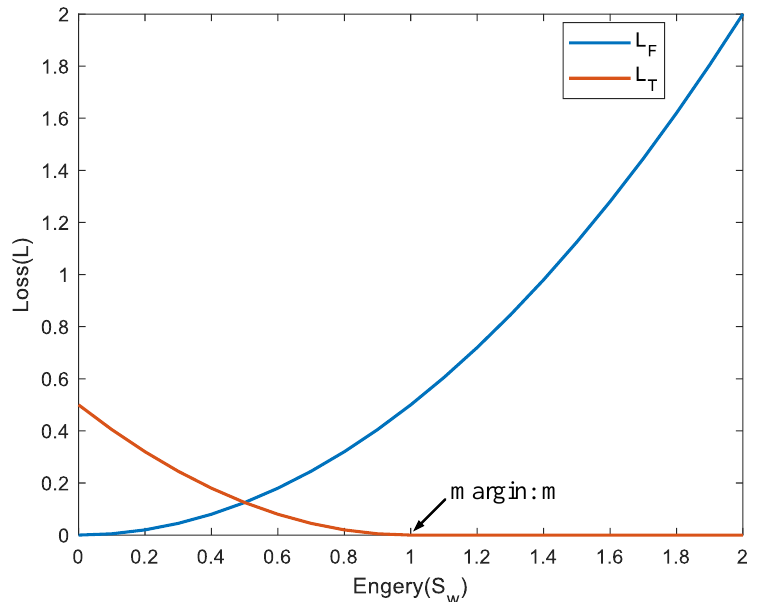
Figure 8. Graph of the loss function L with the energy S W . The red line is the loss function L T ( • ) for similar samples and the blue line is the loss function L F ( • ) for dissimilar